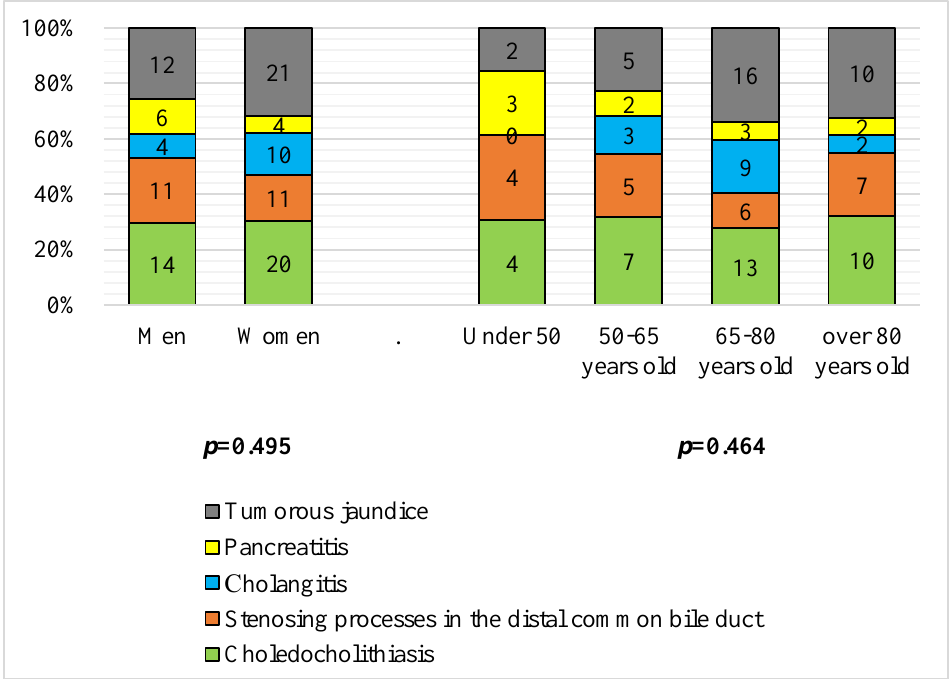
Figure 1. Distribution of males and females ( p = 0.495) of different ages ( p = 0.464) due to the development of OJ ( n = 113); criterion X 2